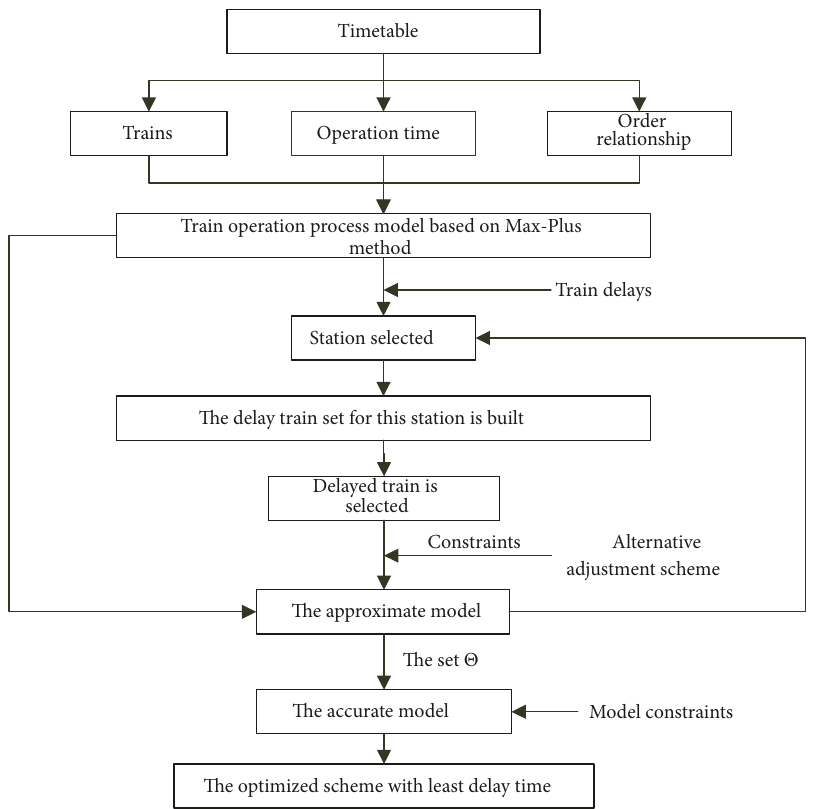
Figure 1: The methodology structure of the